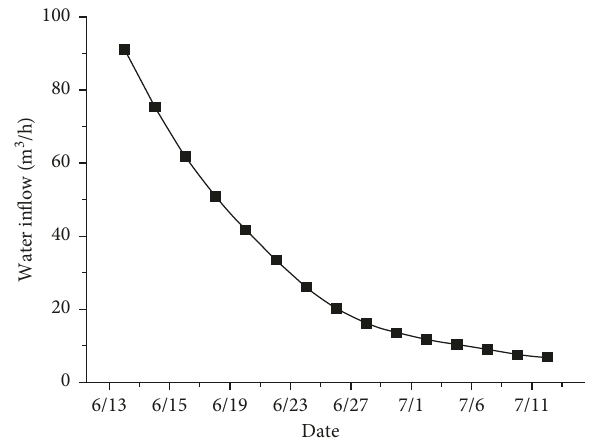
Figure 10: Curve of water inflow.